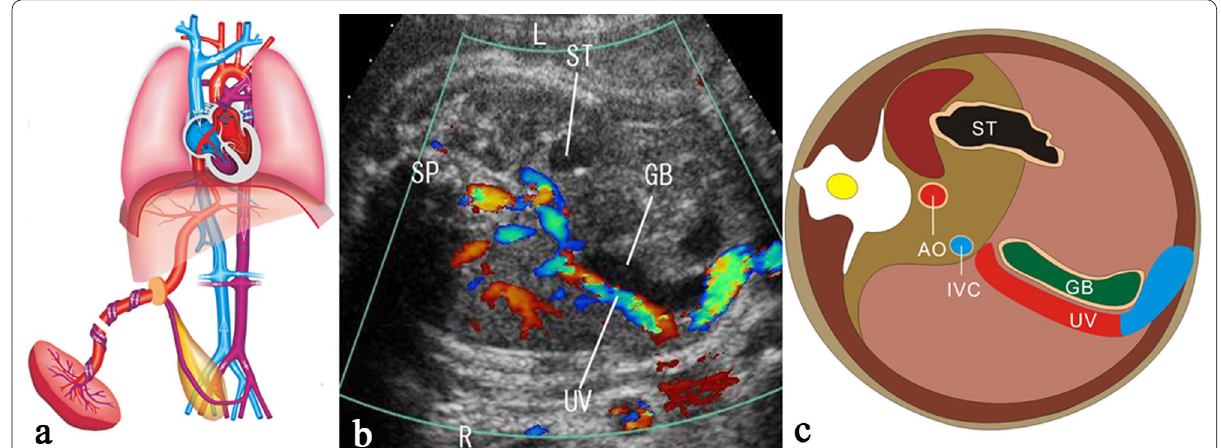
Fig. 8 The scheme ( a , c ) and color Doppler flow imaging ( b ) of intrahepatic PRUV. The cross sections of fetal abdomen ( b , c ) show the RPV turning toward the ST, connecting with a PRUV